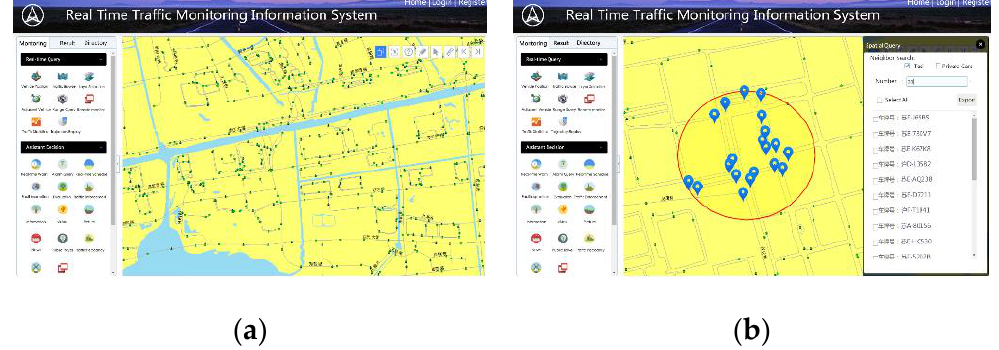
Figure 12. The web interface of our real-time traffic monitoring system, which shows a visualization of moving objects that updates every minute, while the spatial index is updated every second. ( a ) Real-time traffic monitoring; ( b ) nearest neighbor search.